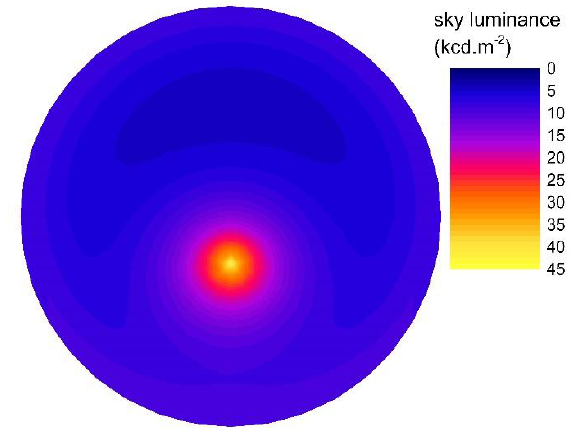
Figure 5. Sky luminance pattern according to the Perez all-weather model computed for case 1.